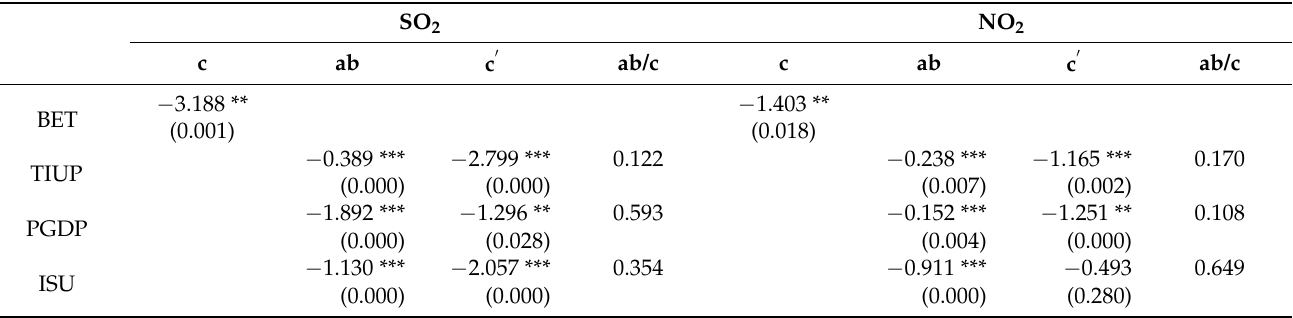
Table 5. Mediating effect on SO 2 and NO 2 .